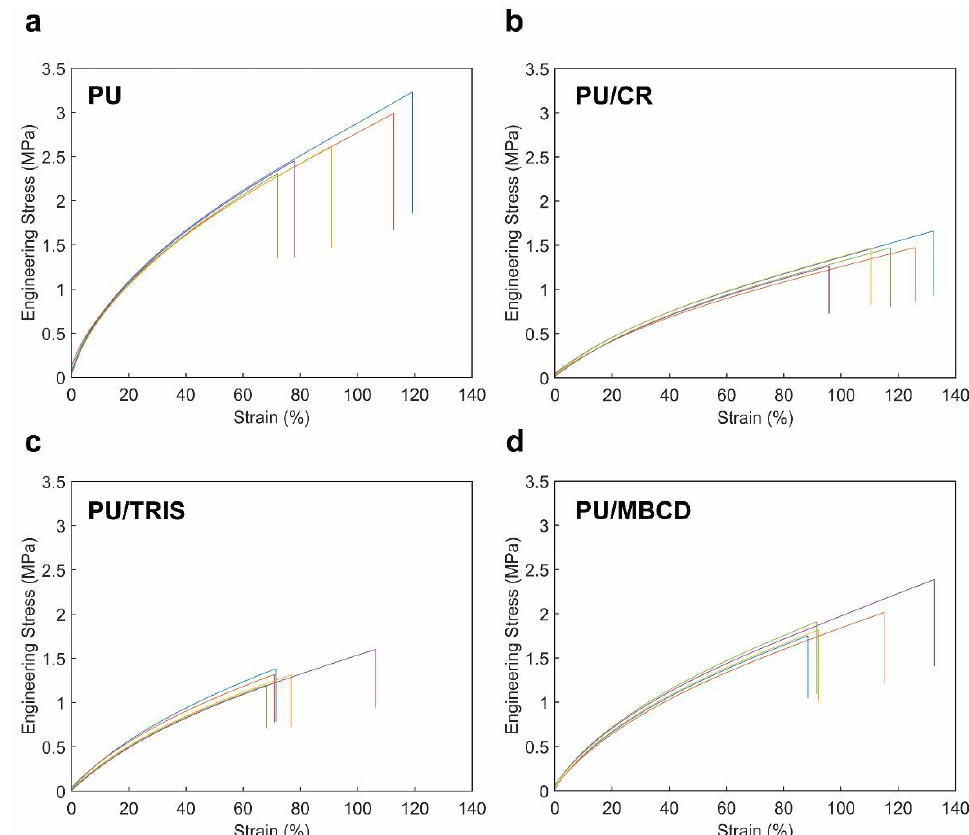
Figure 7. Stress–strain curves obtained for the pure polyurethane and polyurethane blend membranes: ( a ) PU, ( b ) PU/CR, ( c ) PU/TRIS and ( d ) PU/MBCD. Multiple specimens are represented by different colors for each membrane.